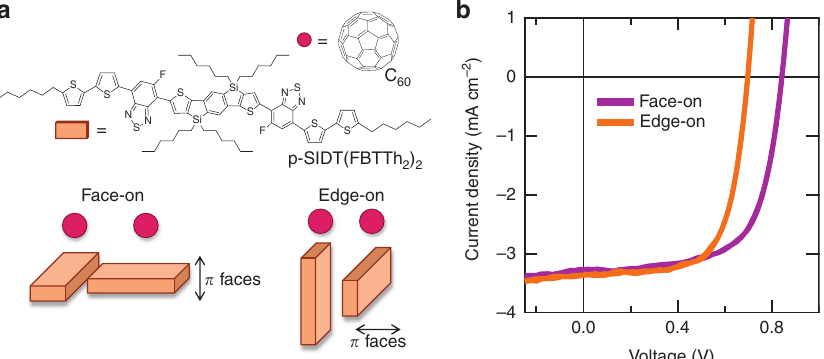
Fig. 1 Molecular orientation and the resulting photovoltaic performance. a Molecular structures of p-SIDT(FBTTh 2 ) 2 and C 60 along a cartoon depicting the relative orientations of the two molecules in the face-on and edge-on bilayer samples; b Current-voltage characteristics of bilayer devices under 1 sun